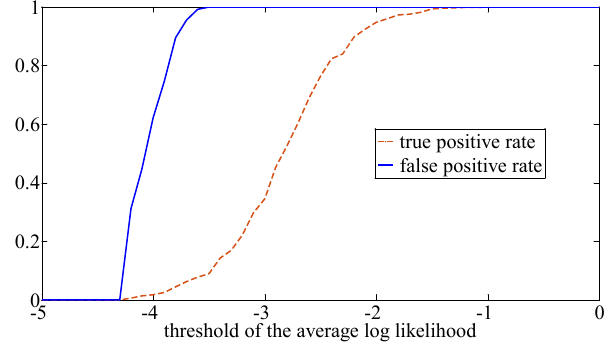
Fig. 2. Adjusting threshold values on Weibo data